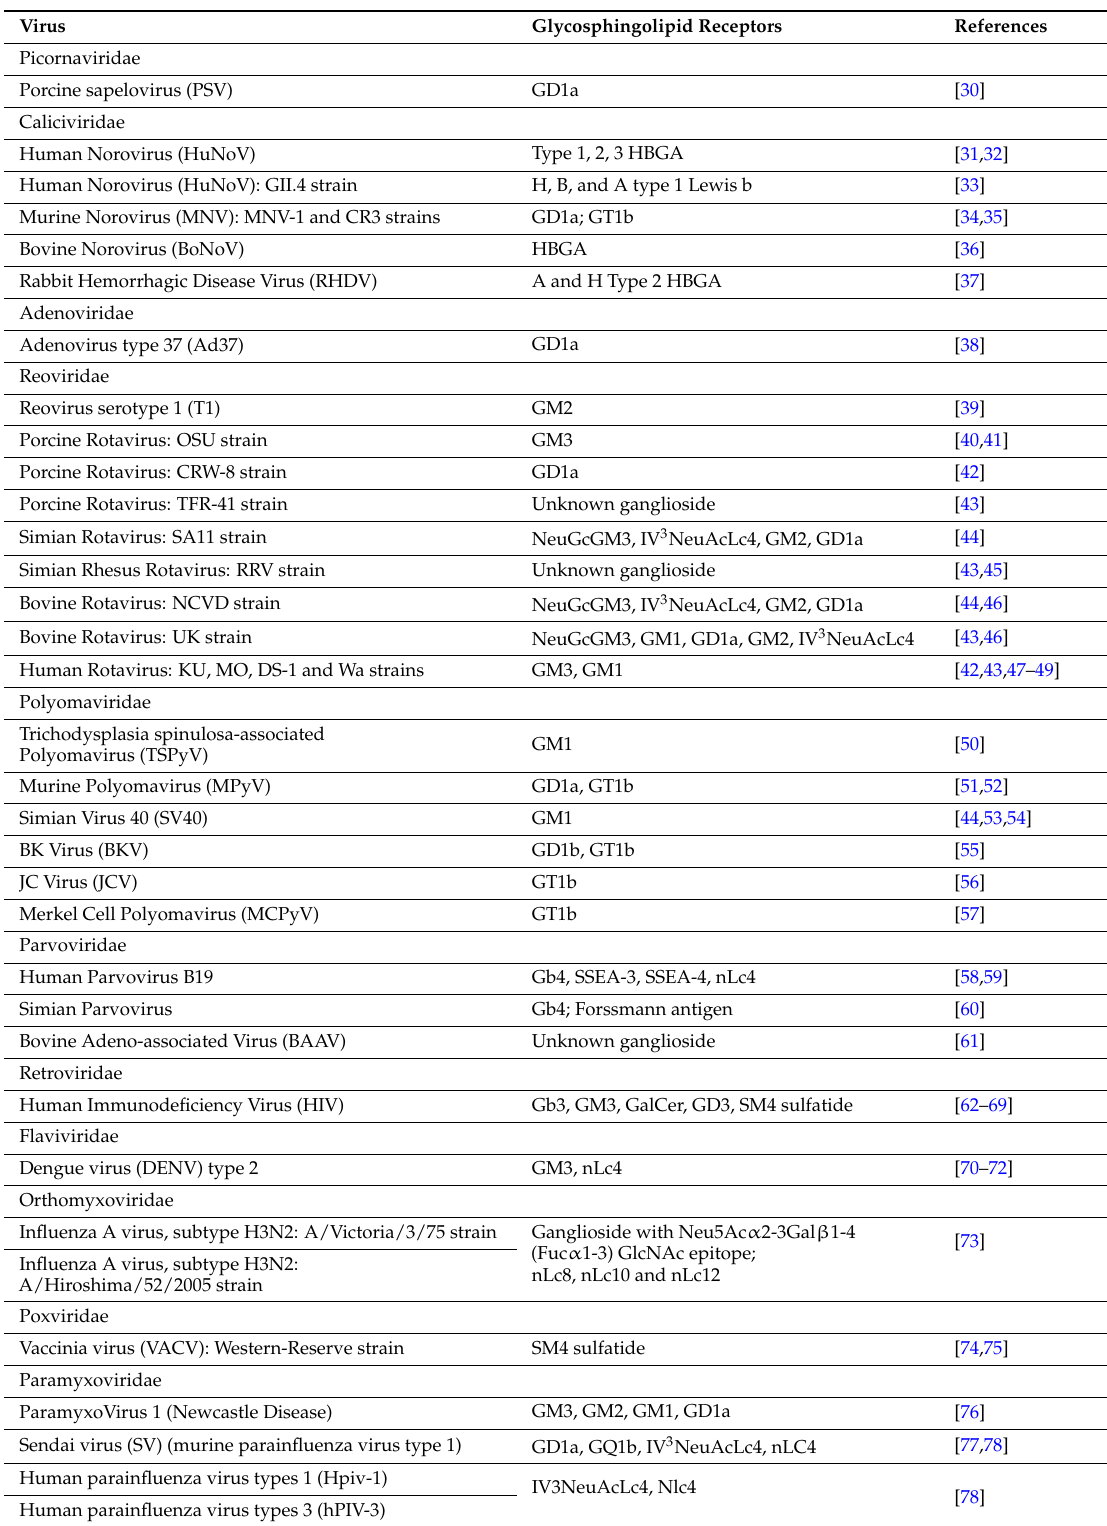
Table 1. Glycosphingolipids (GSLs) headgroups serve as receptors for viruses and bacterial toxins. Virus Glycosphingolipid